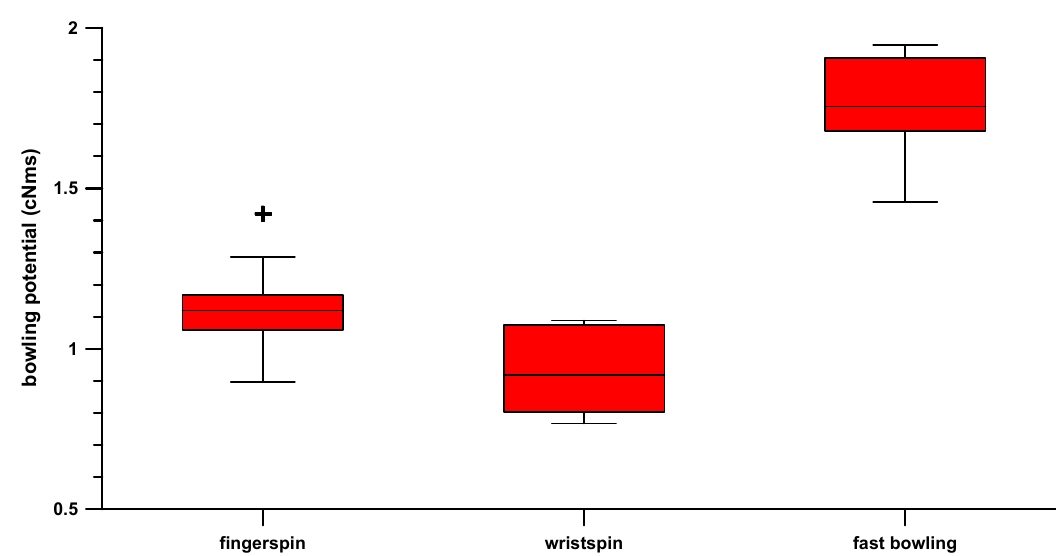
Figure 2. Box and whisker-plot of the bowling potential within each group (in cNms, centi-Newton- meter-second); + =